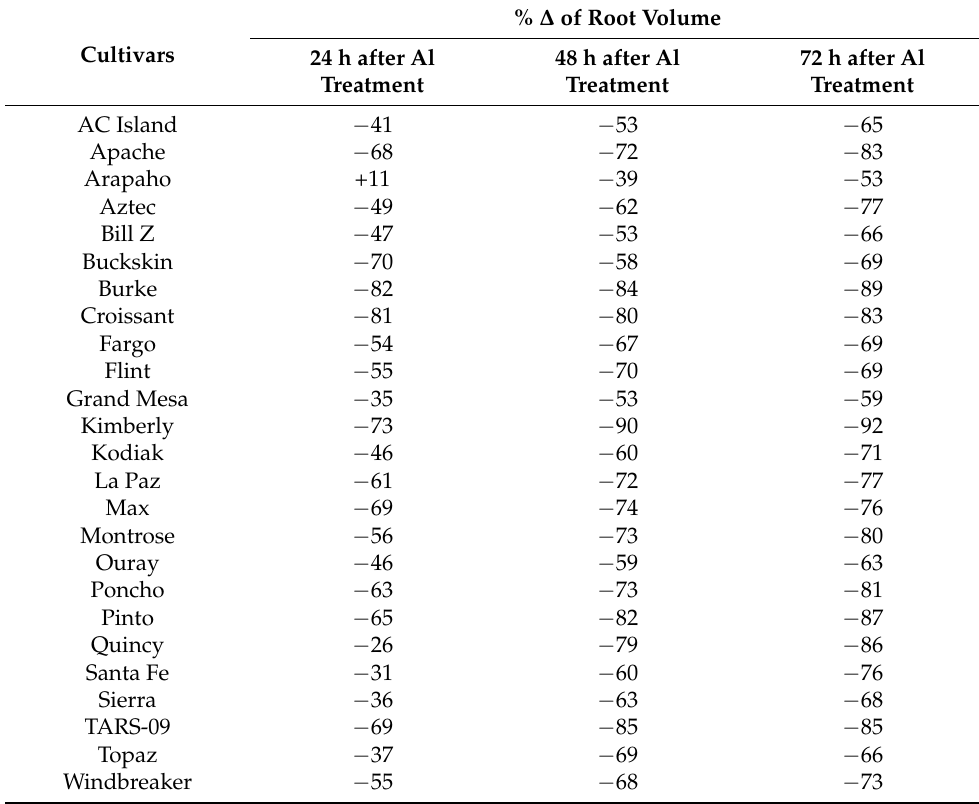
Table 2. The change in root volume percentages of 25 Pinto bean cultivars 24, 48, and 72 h after AlCl 3 treatment, relative to non-stressed